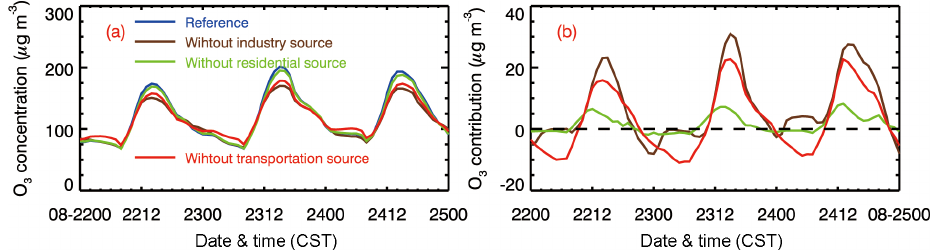
Figure 19. Diurnal profiles of (a) O 3 concentrations and (b) O 3 contribution from various anthropogenic sources averaged in Xi’an and surrounding areas from 22 to 24 August 2013. Blue line: the reference simulation; brown line: the simulation without industry emissions; green line: the simulation without residential emissions; red line: the simulation without transportation